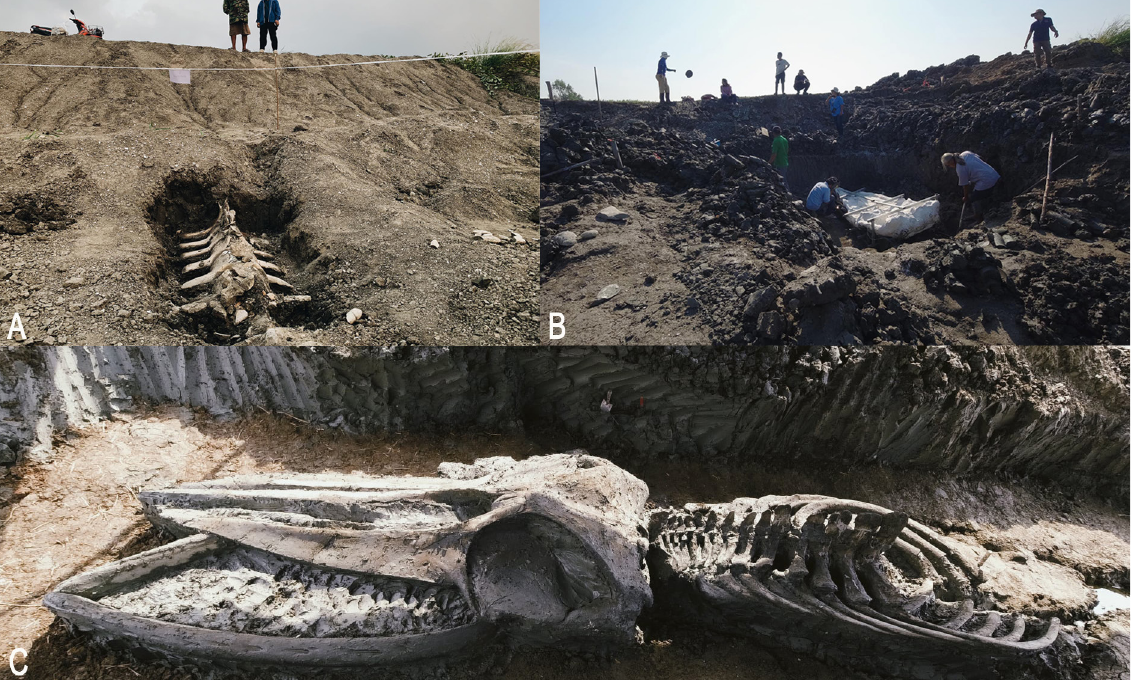
Fig. 1. Whale-fall excavation site, fifteen kilometers away from recent shoreline in Samut Sakhon Province, north of the Gulf of Thailand. A . First appearance of large skeletons eroded off the pit wall. B . The excavation during November–December 2020. C . Nearly complete, well preserved whale skeleton. All photos from ThaiWhales